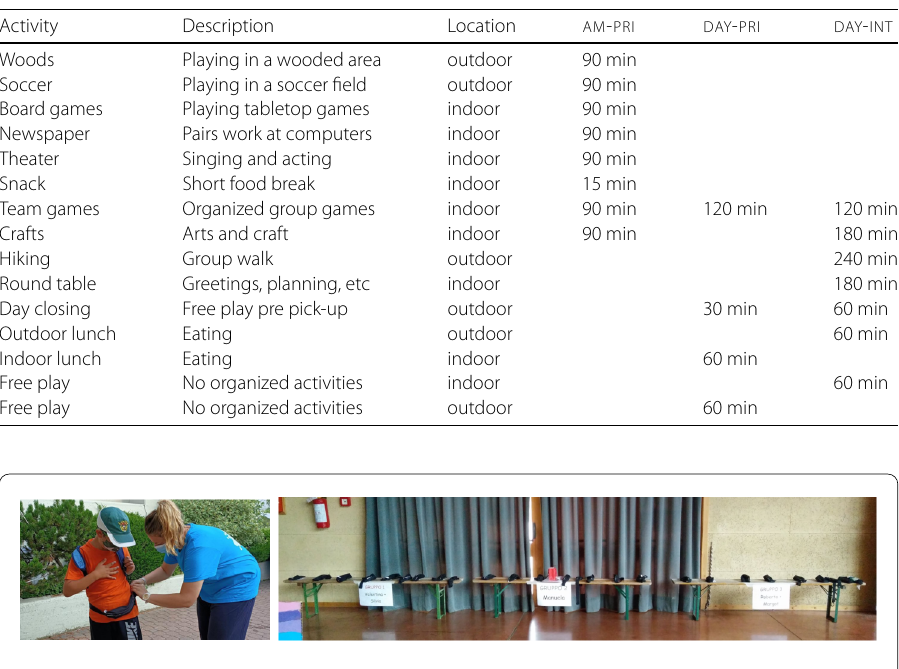
Figure 2 Janus device management at the AM - PRI camp. Left: An educator fitting the waist bag containing the device on a child, on the first camp day. Right: Devices in waist bags sitting on a storage bench overnight; the inhibitor device is inside the red bag in the